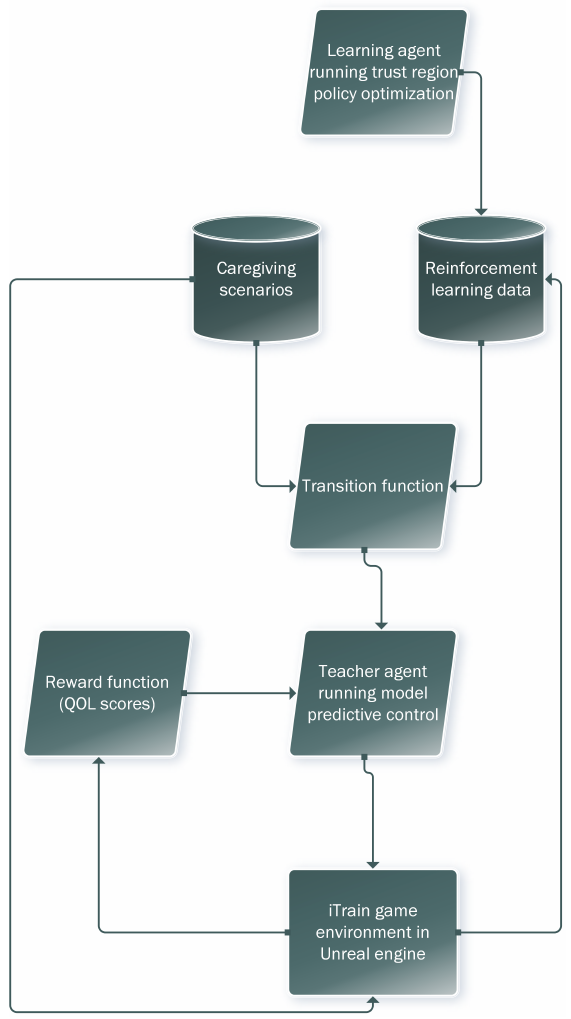
Figure 1. Reinforcement learning-based model for the iTrain